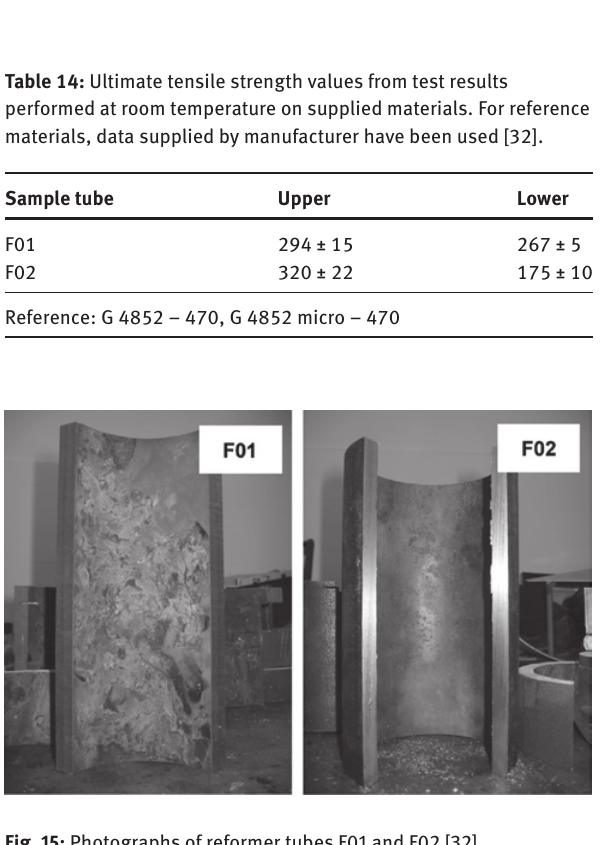
Fig. 15: Photographs of reformer tubes F01 and F02